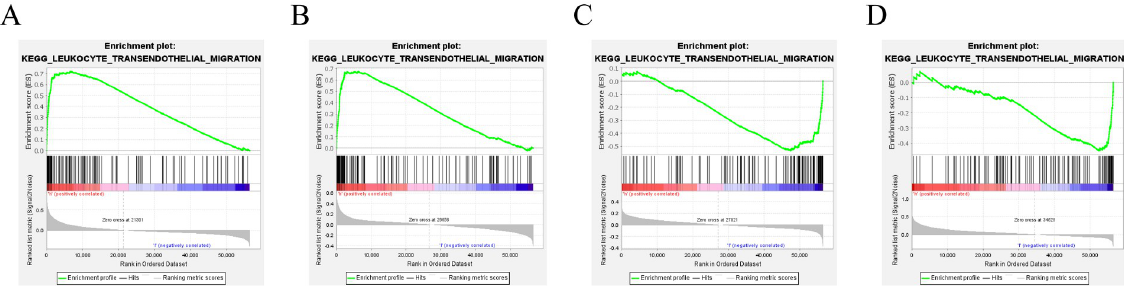
Fig 9. Gene set enrichment analysis confirmed that 4 genes in this model including ALOX5(A), DPP4(B), NOX1(C), and PHKG2(D) are all enriched in leukocyte transendothelial